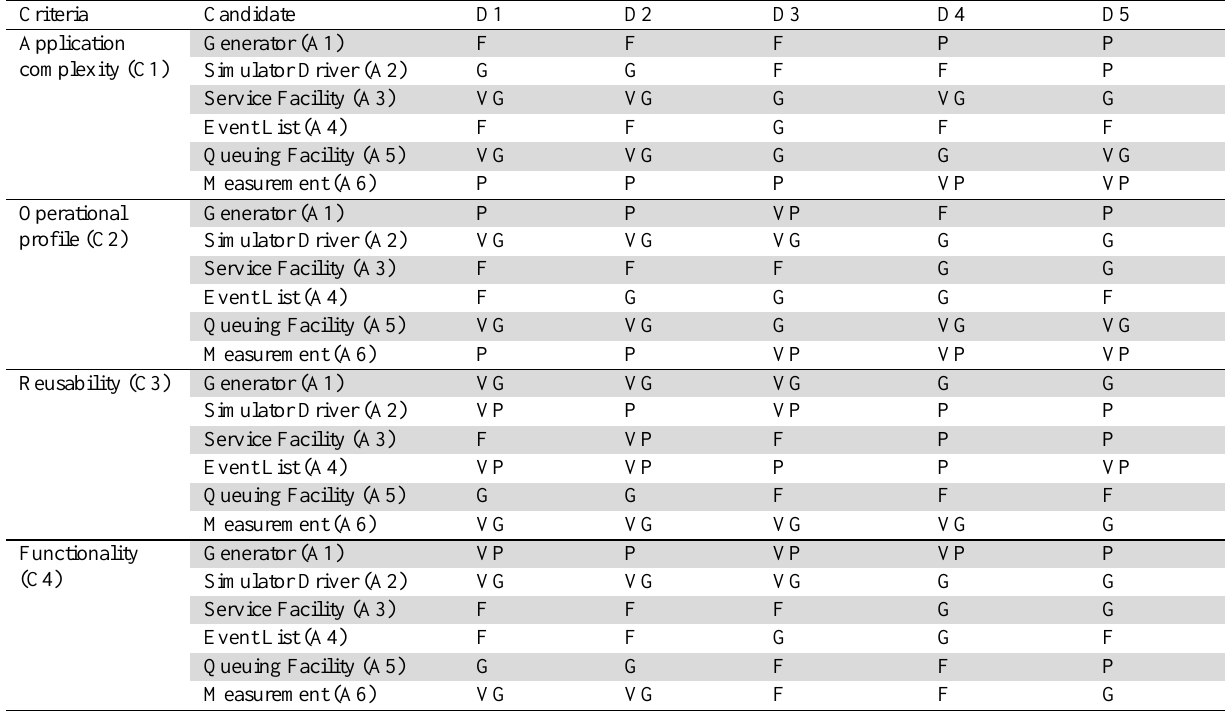
Reliability ranking assignment matrix for WQS Criteria